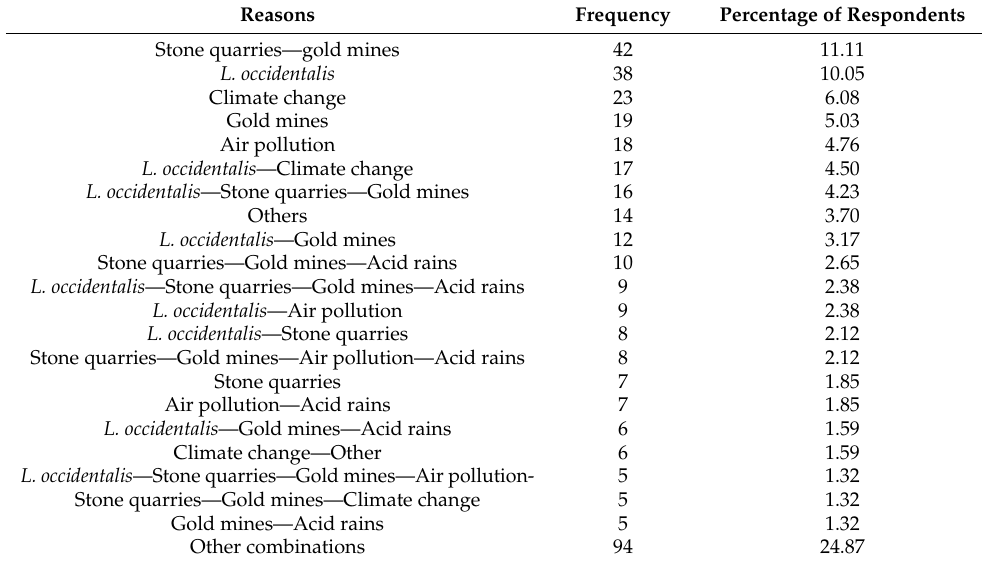
Table 7. Reasons for yield reduction from the farmers’